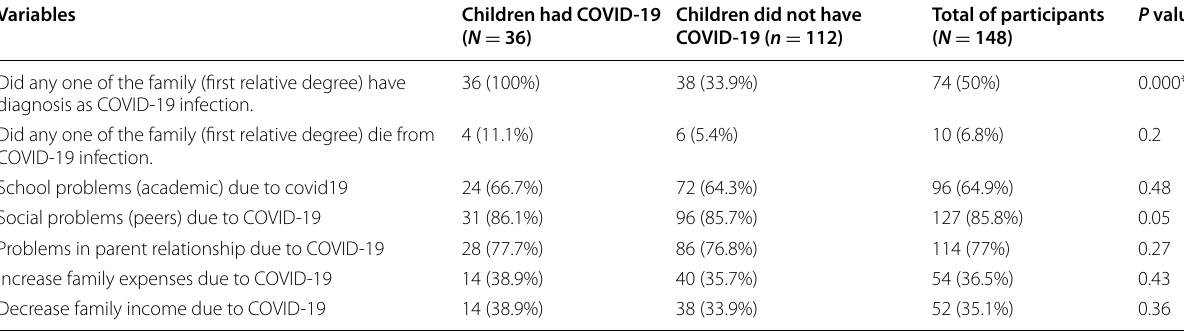
*Significant p value